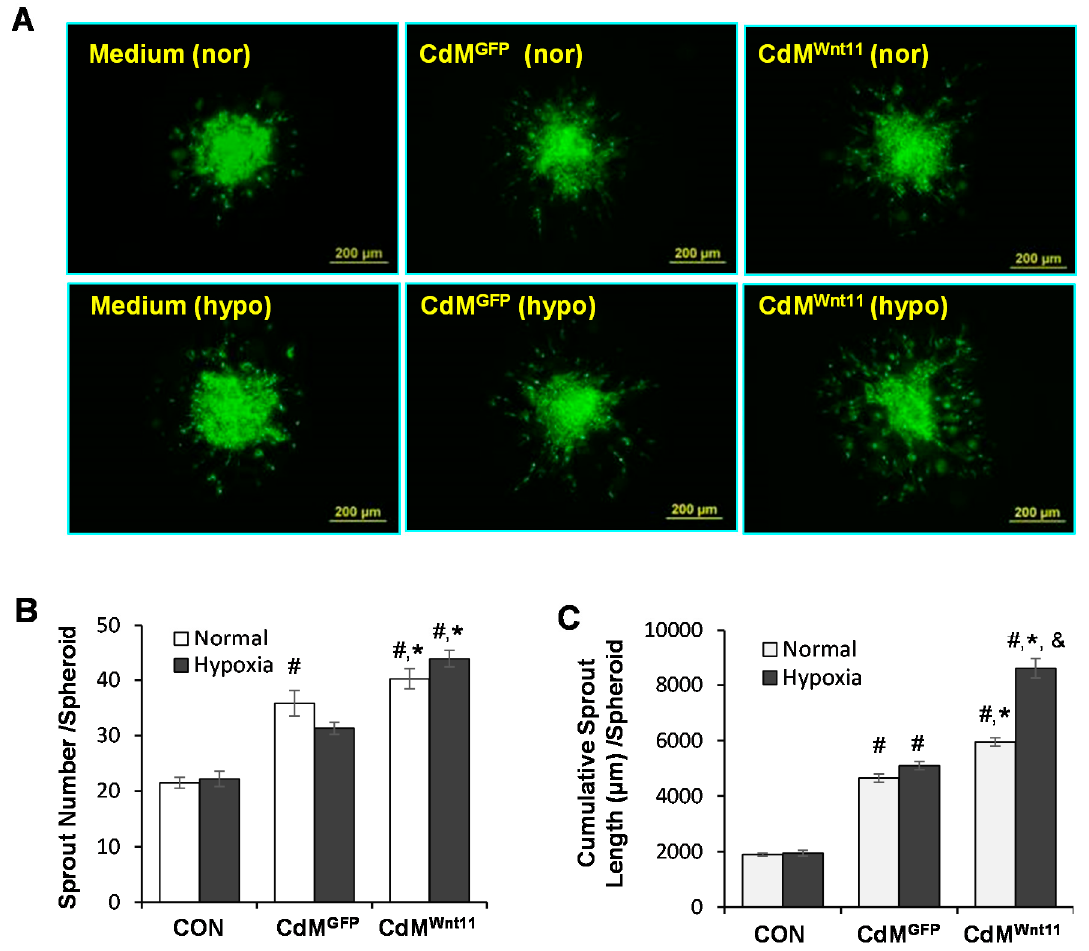
Figure 3. CdM from MSCs overexpressing Wnt11 promotes angiogenic sprouting of HUVECs. ( A ): Representative images of HUVEC sprout from spheroids underwent different treatments for 24 h. ( B ): Quantitative data of sprout number from each spheroid. ( C ): Quantitative data of sprout length from each spheroid. # , p < 0.05 vs. CON; *, p < 0.05 vs. CdM GFP ; & , p < 0.05 vs. CdM obtained from MSCs exposed to normal culture, respectively.